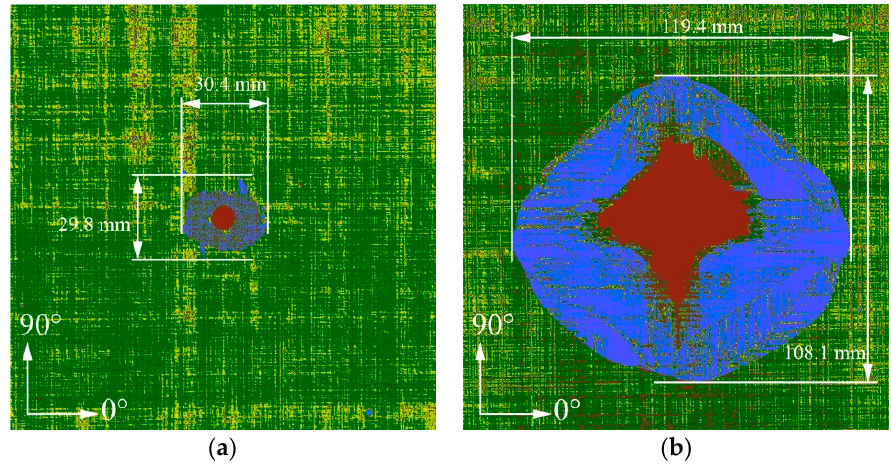
Figure 7. Ultrasonic C-scan results of specimens after lightning strikes: ( a ) component C; ( b ) component D.